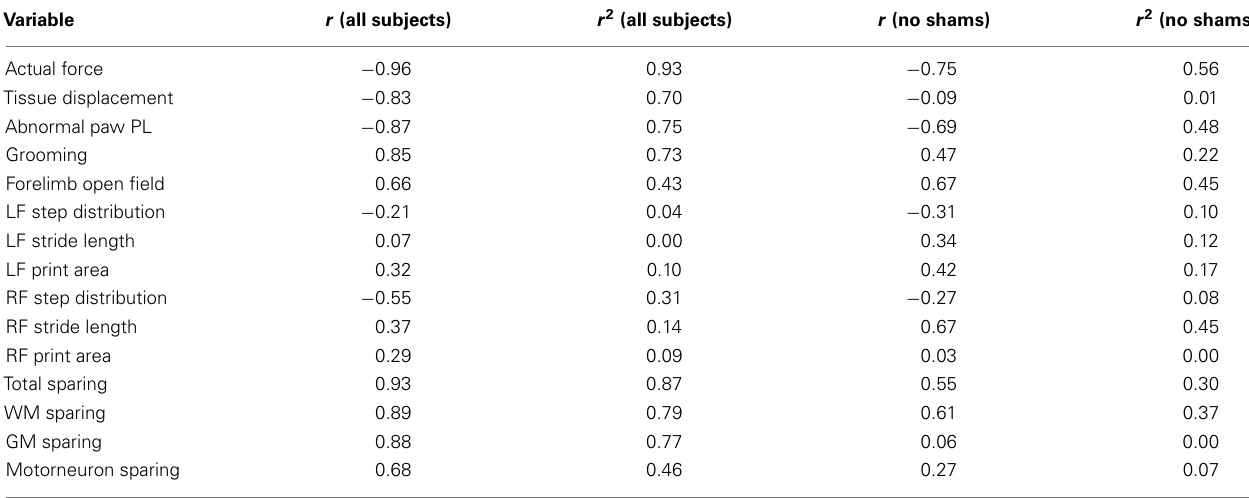
Table 2 | Correlations of individual variables with IBB score